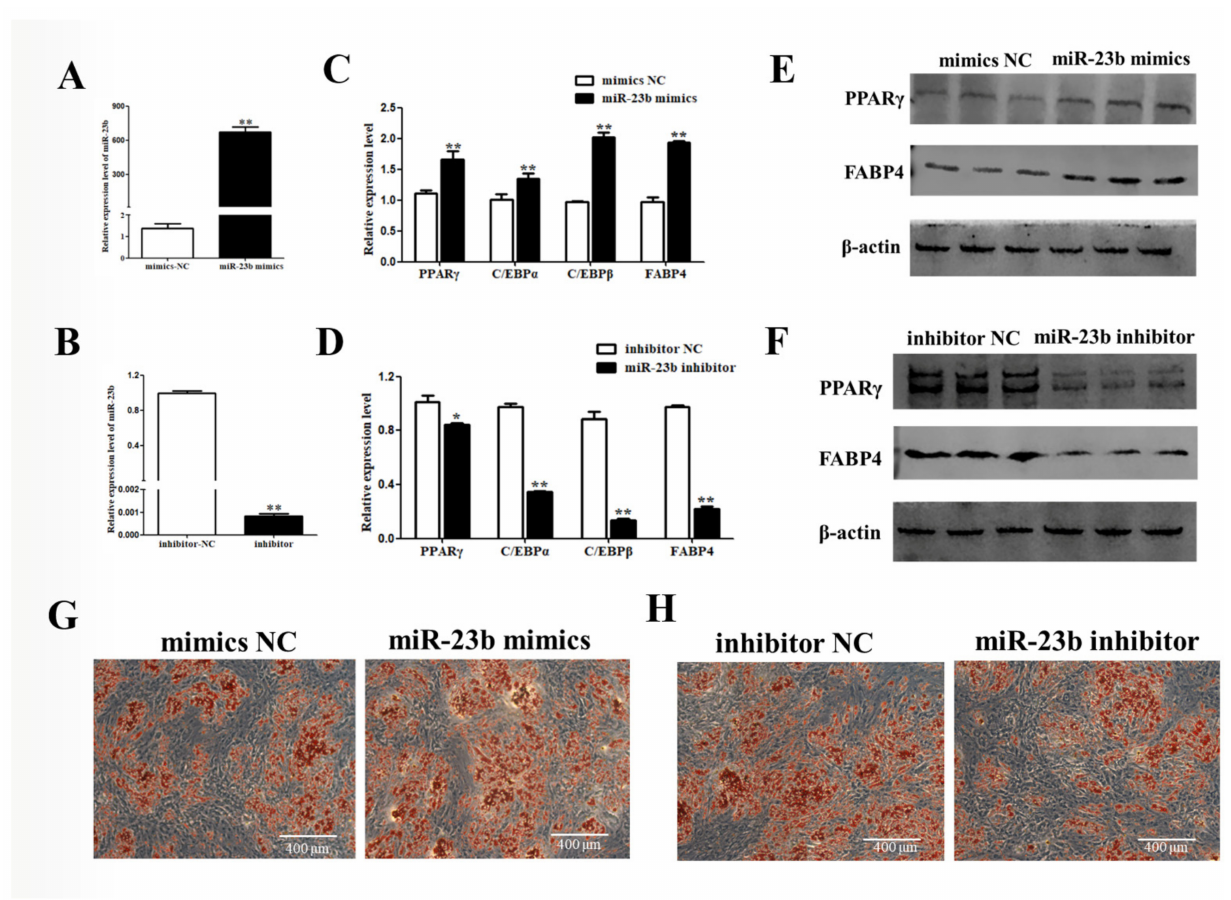
Figure 2. miR-23b promotes adipogenic differentiation of porcine precursor adipocytes. ( A , B ) Cell transfection efficiency; ( C , D ) expression changes of adipogenic factors at mRNA level; ( E , F ) expres- sion changes of adipogenic factors at protein level; ( G , H ) the results of Oil Red O staining. Note: * indicted significant difference at 0.05 level, and ** indicted significant difference at 0.01